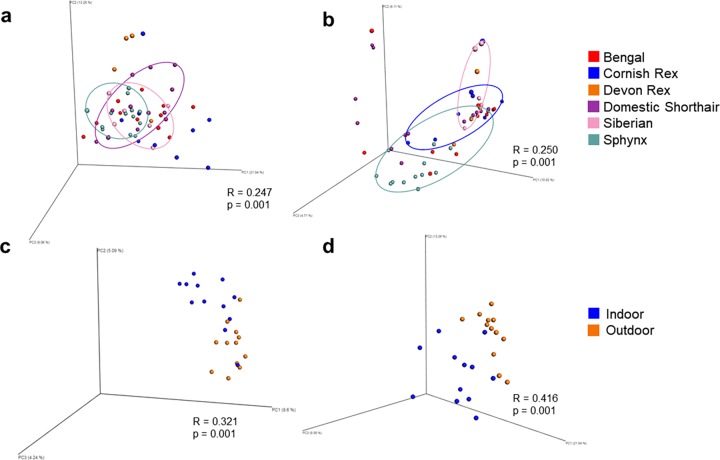
Principle coordinate analysis (PCoA) plots of beta diversity distance matrices comparing different cat breeds and indoor and outdoor cats.Comparing beta diversity of (a) bacterial communities on the dorsum between cat breeds with the weighted UniFrac metric, (b) fungal communities on the dorsum between cat breeds with the Bray-Curtis metric, (c) bacterial communities in the oral cavity between indoor and outdoor cats with the Bray-Curtis metric, and (d) bacterial communities in the oral cavity between indoor and outdoor cats with the weighted UniFrac metric. R and p-values are from analysis of similarities (ANOSIM) test of beta diversity distance matrices.